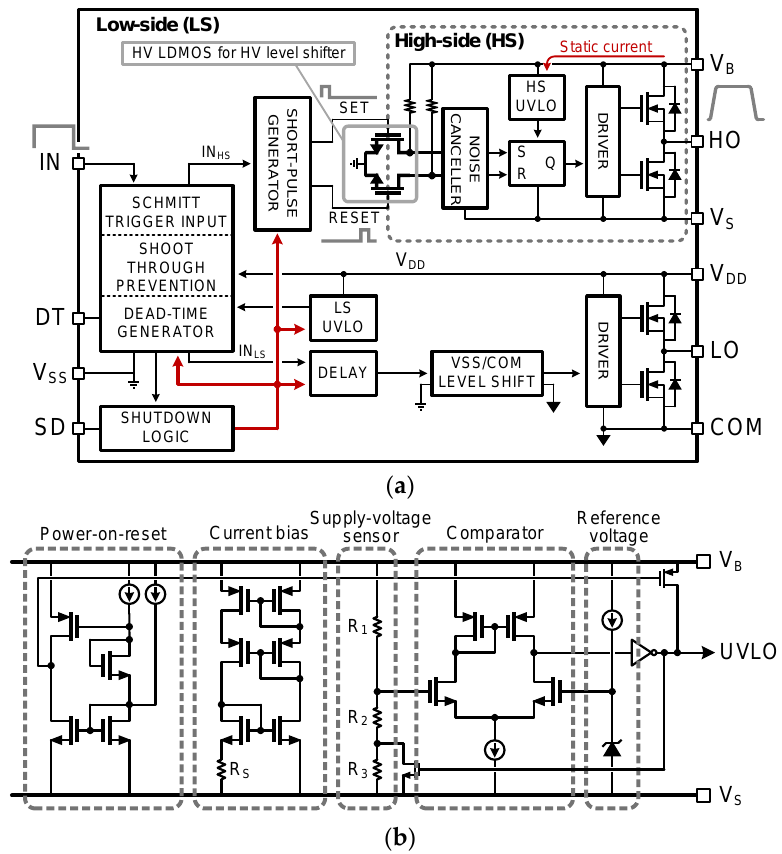
Figure 2. High-voltage gate driver. ( a ) Full block diagram. ( b ) Conventional high-side under-voltage lockout circuit.